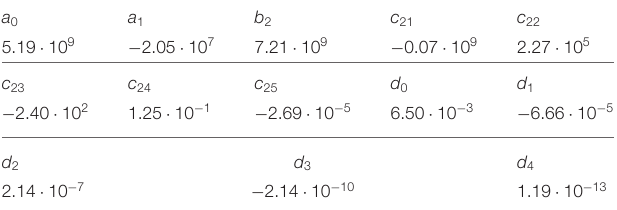
TABLE 1 | Values assigned to the coefficients of the polynomial series developments of state evolution function (5) and memductance function (6) in the proposed NbO micro-device model (3) and